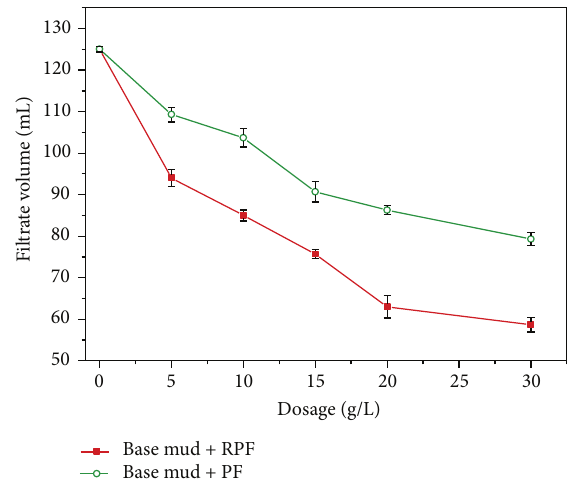
Figure 9: The effect of RPF and PF concentration on the HTHP filtration loss of fresh water